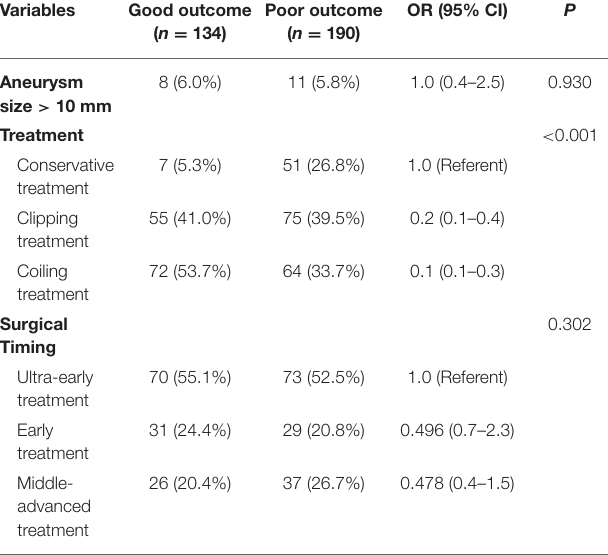
Table 1 also described the results of the univariate analyses for the association between clinical variables and poor outcomes. group, and the rest patients were assigned as good outcome